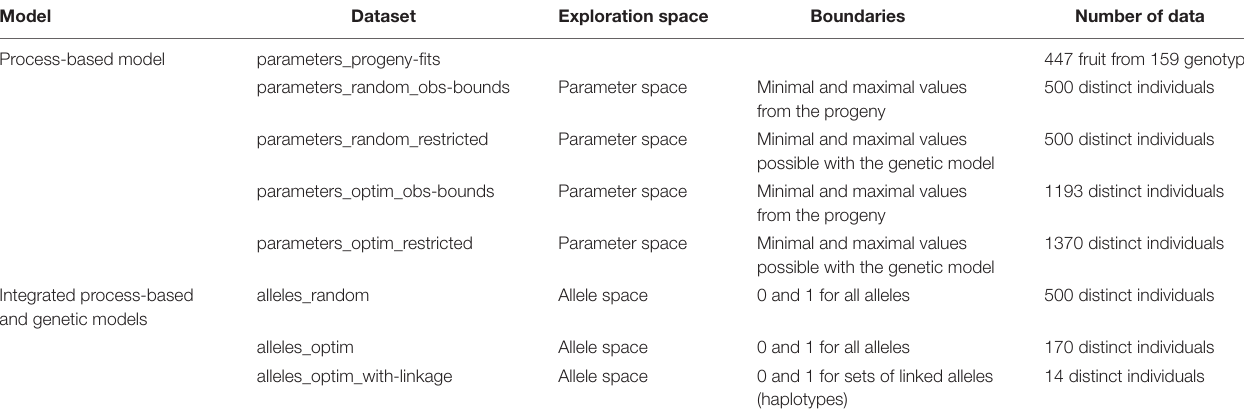
TABLE 3 | Description of the eight datasets including parameter or allele values and the corresponding simulated phenotypes.